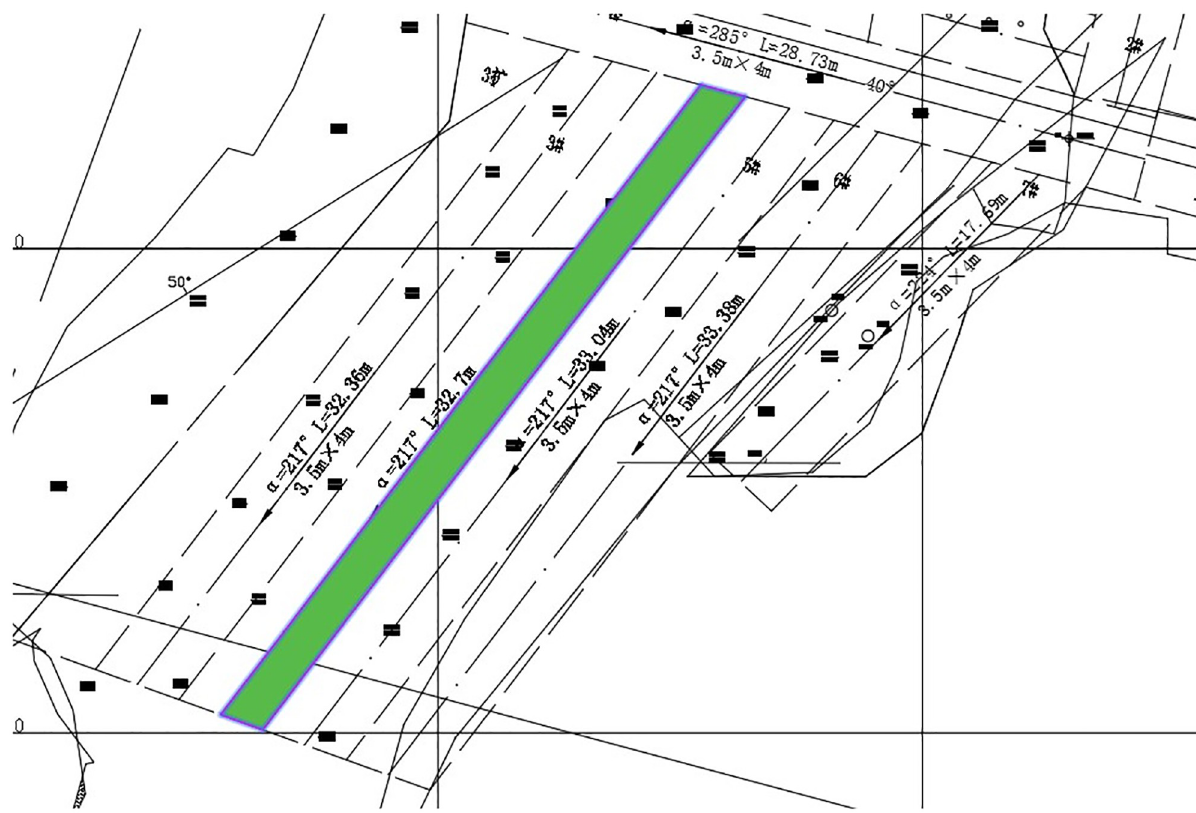
Fig 10. Experimental evaluation of stope